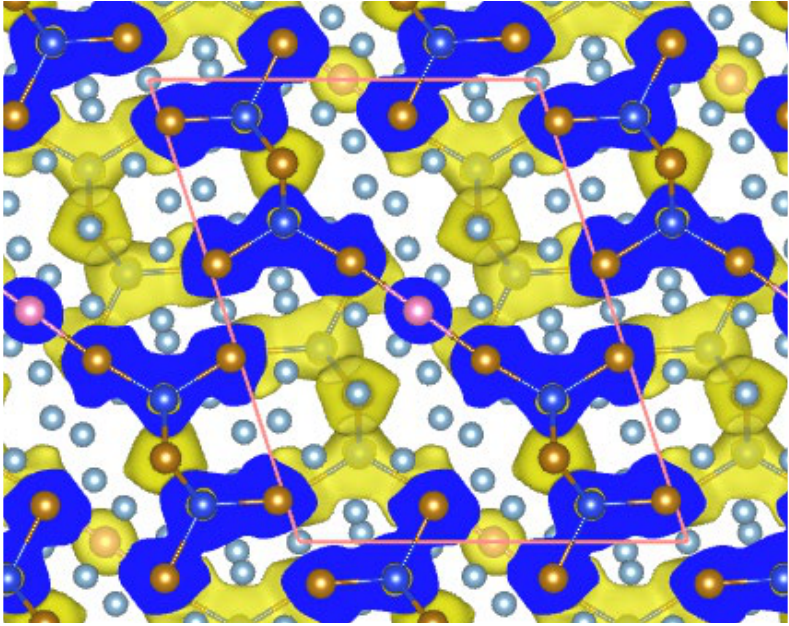
Figure 3. Electron density distributions in θ -Al 68 Cu 2 Si 8 Fe 24 with electron density iso-surfaces (the yellow clouds, ρ 0 ( r ) = 0.045e/Å 3 ). The meaning of the spheres is the same as Figure 2. The Si-Fe-Si clusters are indicated by the pink lines.